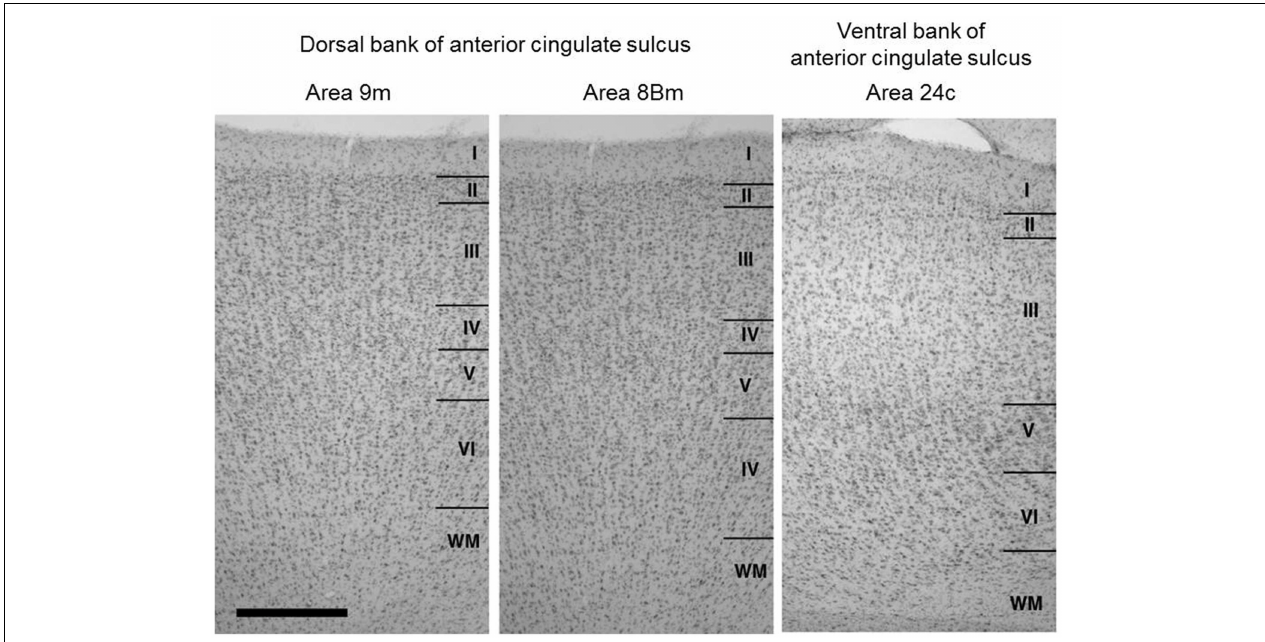
FIGURE 2 | Cytoarchitecture of the cortical areas around the injection sites (dorsal bank parts of areas 9m and 8Bm) together with that of the neighboring cortical area in the ventral bank of anterior cingulate sulcus (area 24c). Arabic numbers indicate layer numbers. Scale bar, 5mm.